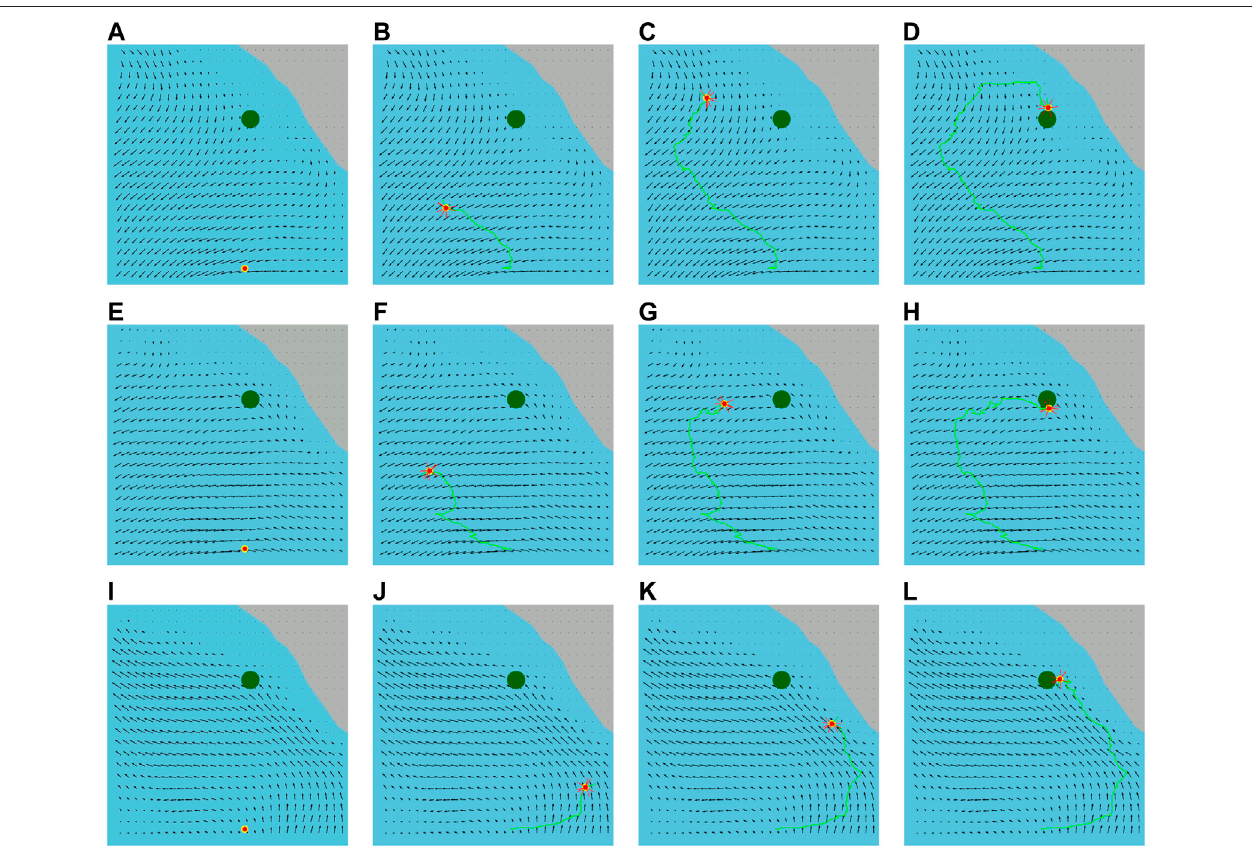
FIGURE 5 | Executed trajectories delineated with the green lines of the vehicle (red circle) from its initial location to the goal location (green circle) applying the synthesized feedback plans for the fi rst water current layer (surface layer) in (A) – (D) and for the third water current layer in (E) – (H) and for the sixth water current layer in (I) – (L) . The red lines around the vehicle represent a set of preferred actions of a belief state.